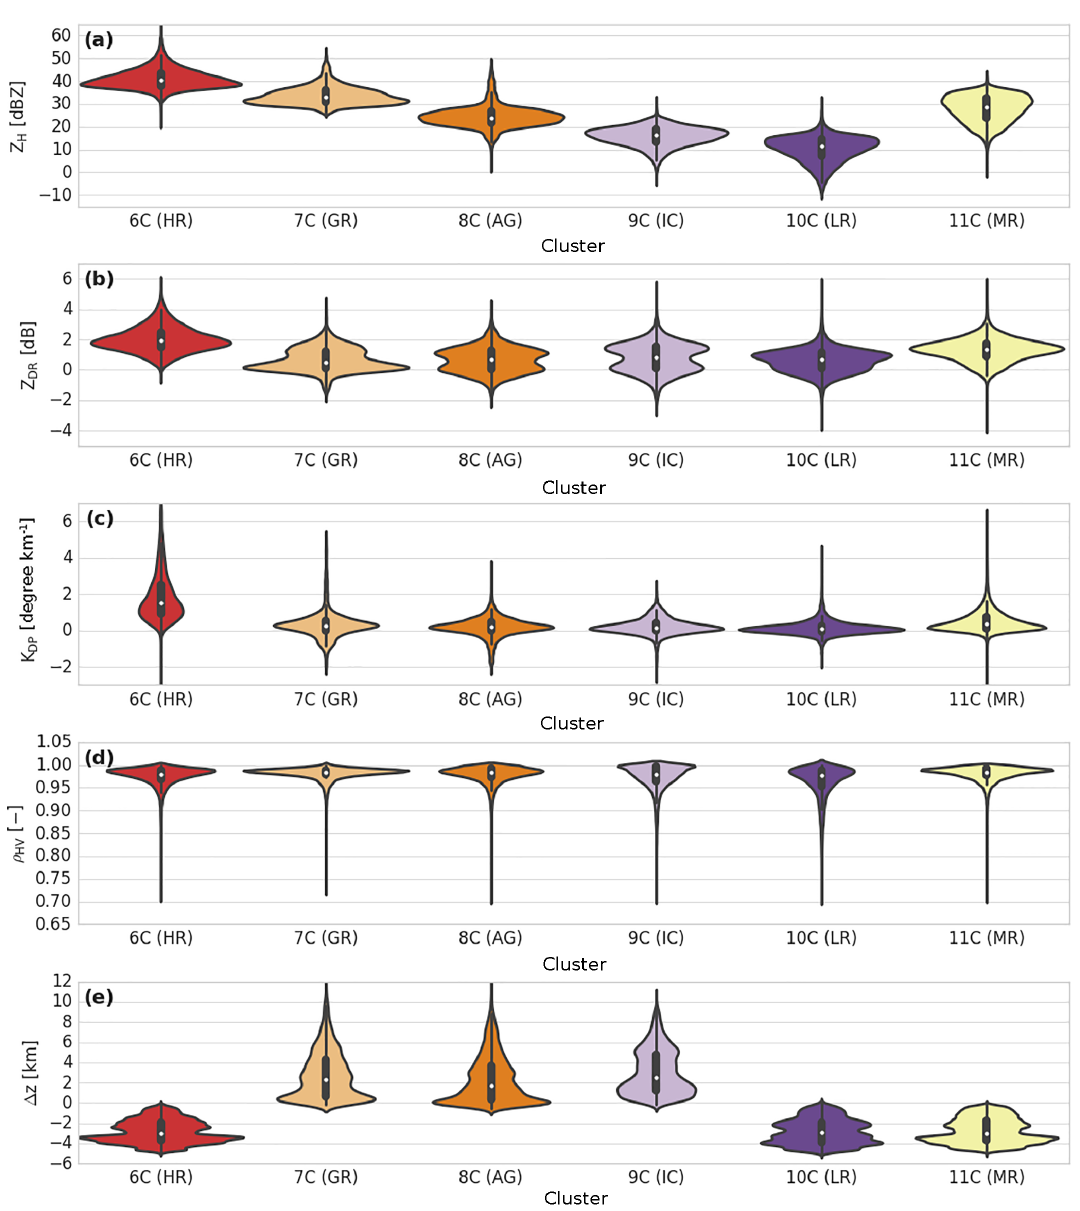
Figure 8. Same as Fig. 7, but for the convective regime of the wet season (LR is light rain, MR is moderate rain, HR is heavy rain, GR is graupel, AG is aggregates, and IC is ice